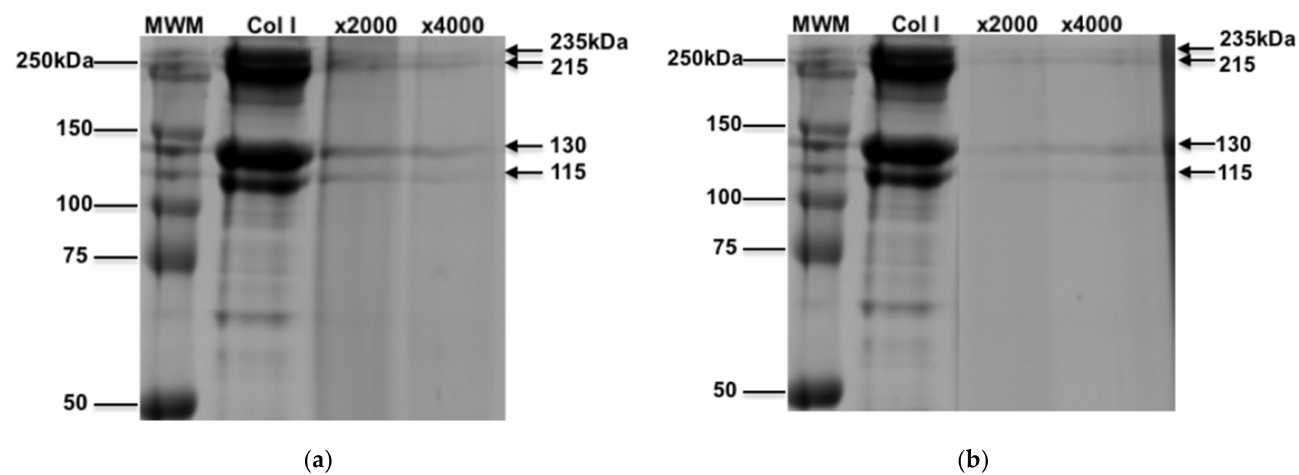
Figure 1. Coomassie blue staining of HOCl-oxidised type I collagen SDS-PAGE gel. Type I collagen (20 µ g/lane) was electrophoresed on an 8–10% ( v / v ) SDS-PAGE gel under reducing conditions prior to staining with Coomassie Brilliant Blue R-250. The four arrows represent the protein bands (235, 215, 130, 115kDa) present in the type I collagen solution. Type I collagen was incubated with ( a ) HOCl or ( b ) HOBr at molar ratios of 1:2000 and 1:4000 collagen to HOCl for 30 min before loading. The gel presented is a representative gel of 3 independent experiments.